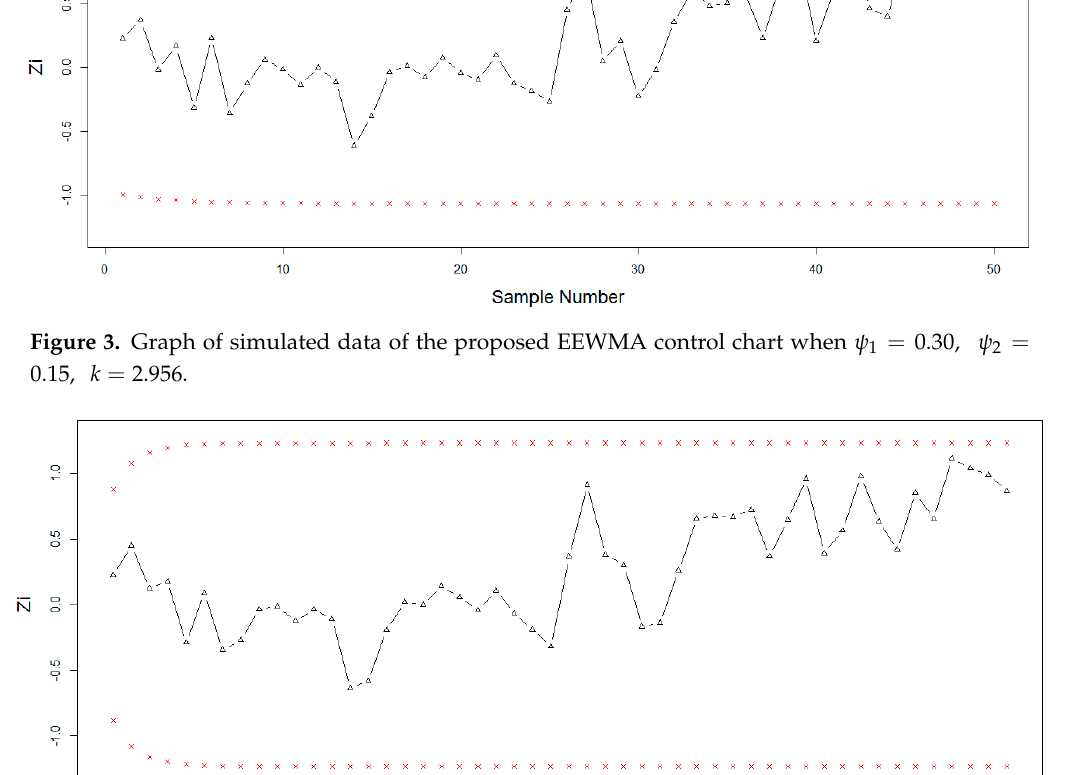
Table 9. Data of urinary tract infections in patients.